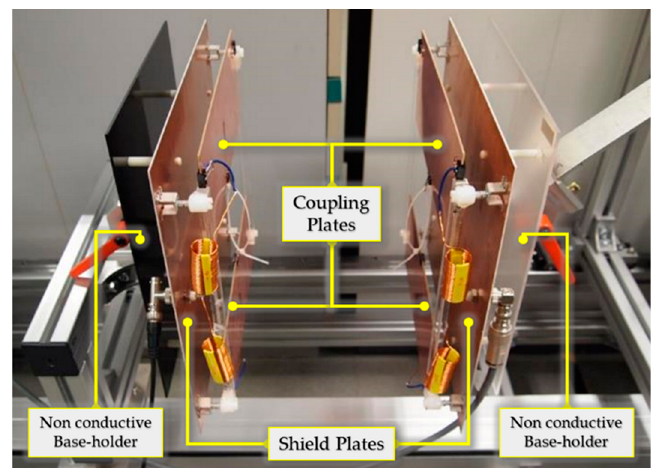
Figure 21. Hardware implementation of the shielded-CPT system.